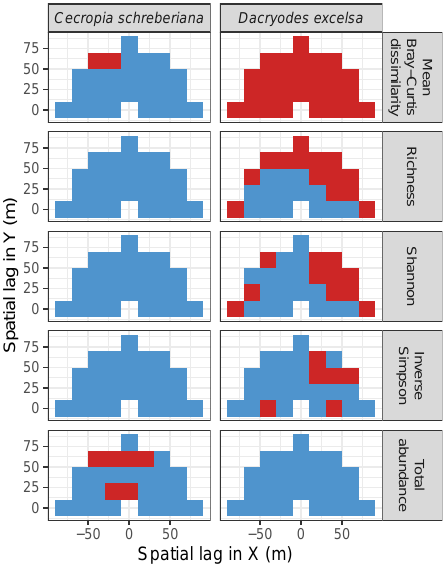
Figure 18. Statistical significance (red: P ≤ 0.05; blue: P > 0.05) of the codispersion coefficients calculated between measures of diversity and total basal area of the two focal tree species in 20 × 20-m subplots in the 16-ha Luquillo plot (Figure 15). Statistical significance was determined by comparing observed codispersion at each spatial lag with a distribution of 199 spatial randomizations of a toroidal-shift null model. See Figure A3 for significance testing using a CSR null model.